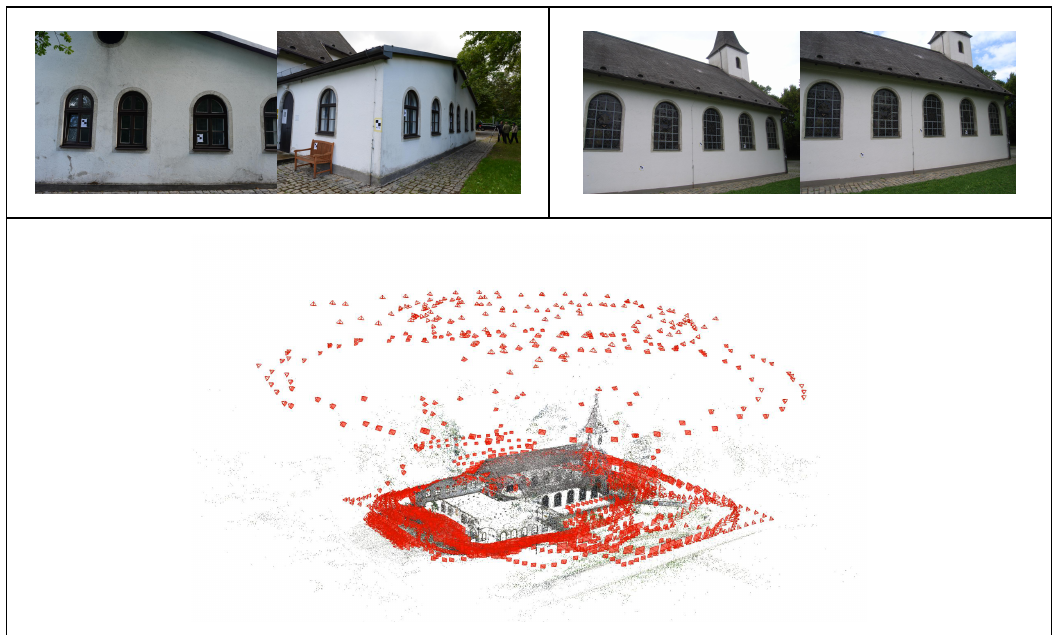
Figure 16. Sample images and our reconstruction result of the Church dataset. The top shows the sample match pairs, and on the left and right are match pairs due to repetitive structure and very short baselines, respectively. The bottom shows our SfM reconstruction